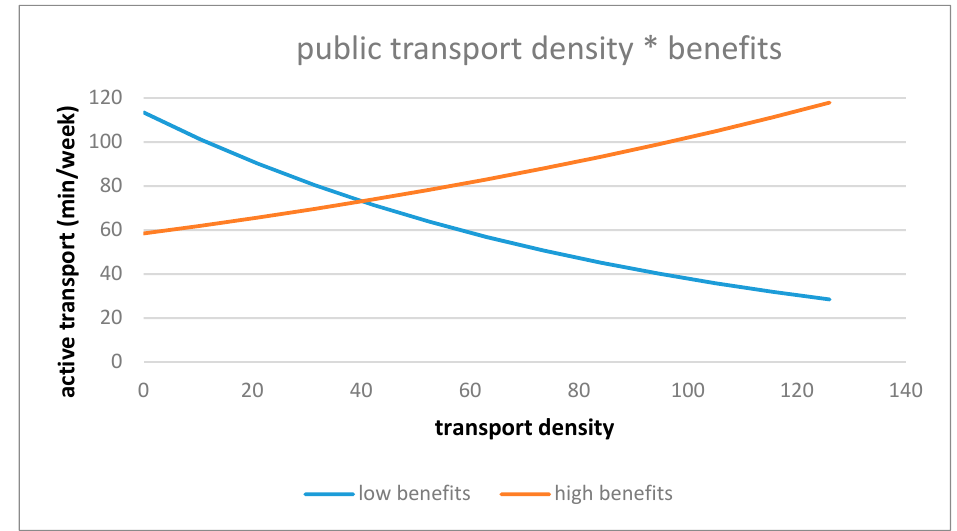
Figure 3. Interaction effect of public transport density and benefits towards PA on active transport.